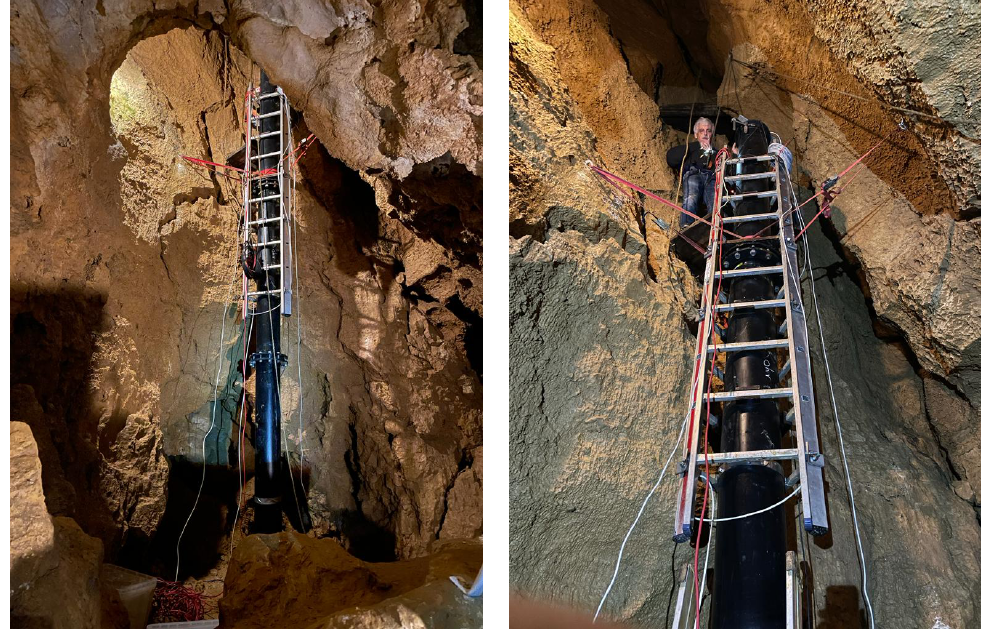
Figure 3. Photos of the column, located in the shaft. For the location of the shaft in the cave, see Figure